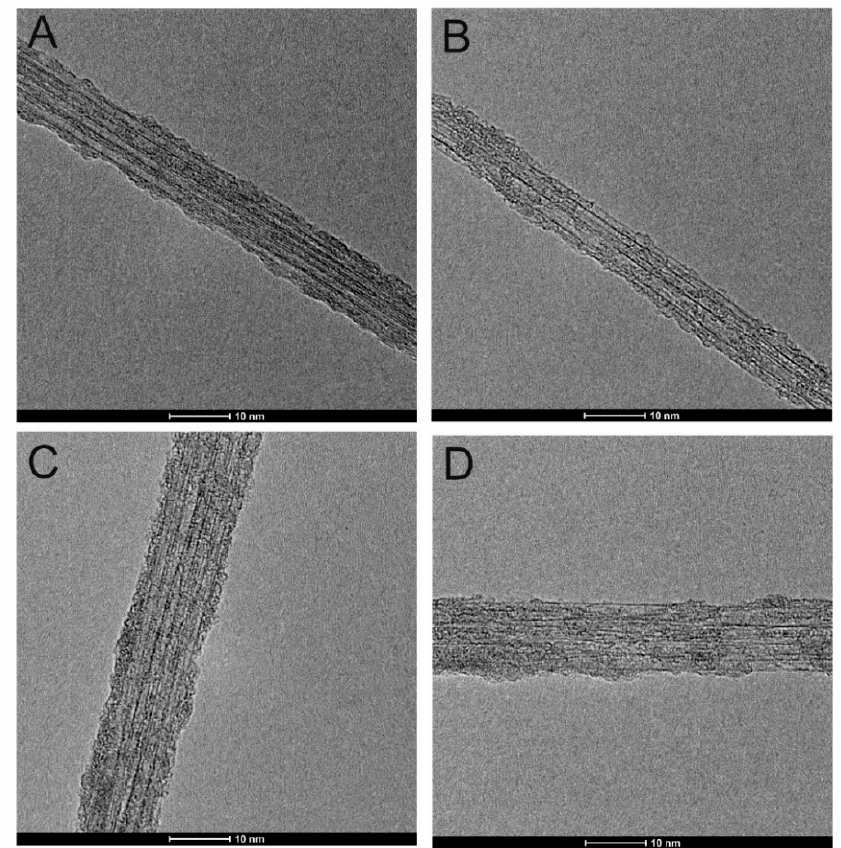
Figure 2. High-Resolution Transmission Microscope images (HRTEM) of chlorinated TUBALL™ single-walled carbon nanotubes (SWCNTs) by their treatment with: ICl 3 ( A ), subjected to an Ullmann-type reaction with phenol ( B ), subjected to Ullmann-type reaction with iodobenzene ( C ), subjected to Ullmann-type reaction with aniline ( D ).